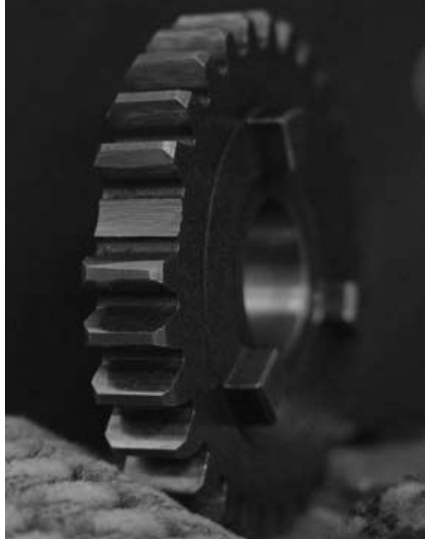
Fig. 4. B4 gear with the broken tooth.